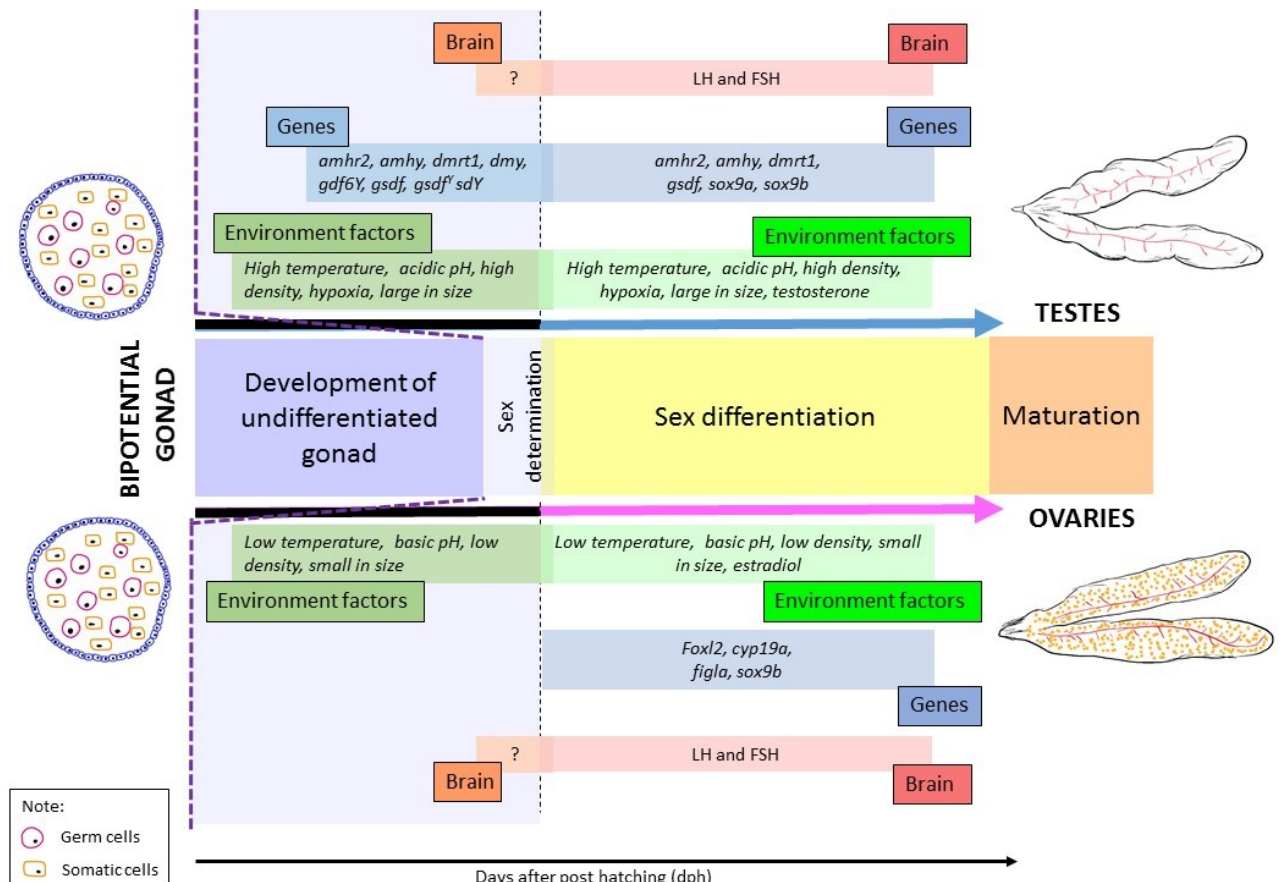
Figure 3. Schematic representation of sex determination/differentiation in teleost. Undifferentiated germ cells need the surrounding somatic cells to provide an instructive signal(s) to initiate sexual differentiation. Therefore, the first step of oogenesis and spermatogenesis is managed by somatic cells [93]. From fish to mammals, Amh signalling plays an important role in gonadal development [13]. In Japanese medaka, gsdf null mutants and amhr2 mutants show excessive growth of germ cells and oocyte arrest during the previtellogenic stage [94]. In zebrafish, gsdf and amh are essential to inhibit the accumulation of premature oocytes [95]. This suggests the expression of gsdf and amh / amhr2 have to be stable during the sex differentiation phase of gonadal development. Reduced gsdf or amh through the amhr2 can directly or indirectly result in protandry [53,97,98]. Ovotestis development is the result of differentially expressed gsdf gene and in amhr2 mutants. Therefore, gsdf and amh signalling is vital for gametogenesis, the production of sex steroids and the secretion of gonadotropins [94].